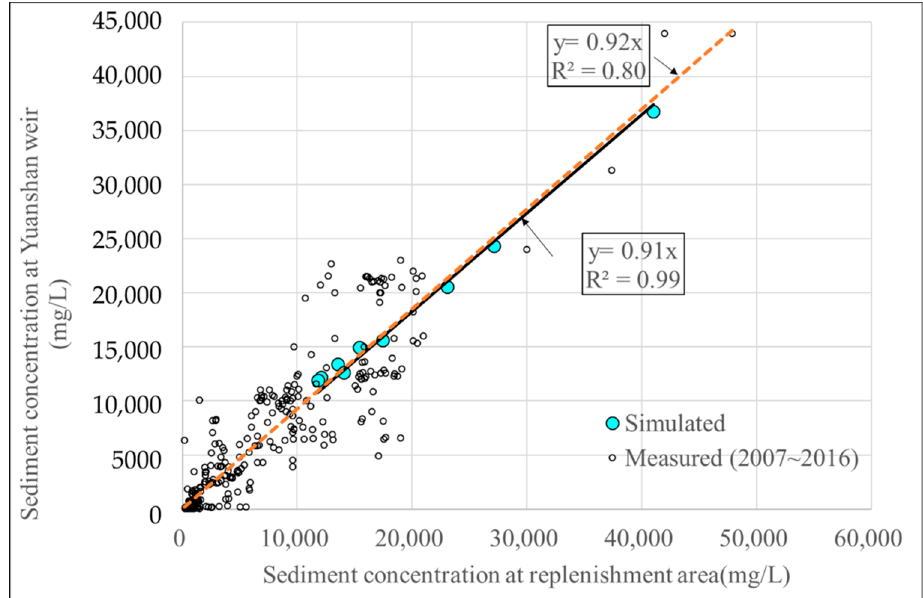
Figure 14. Relationship between sediment concentration in replenishment area and that at the Figure14. Relationshipbetweensedimentconcentrationinreplenishmentareaandthatatthedownstream downstream water intake at Yuanshan weir. water intake at Yuanshan